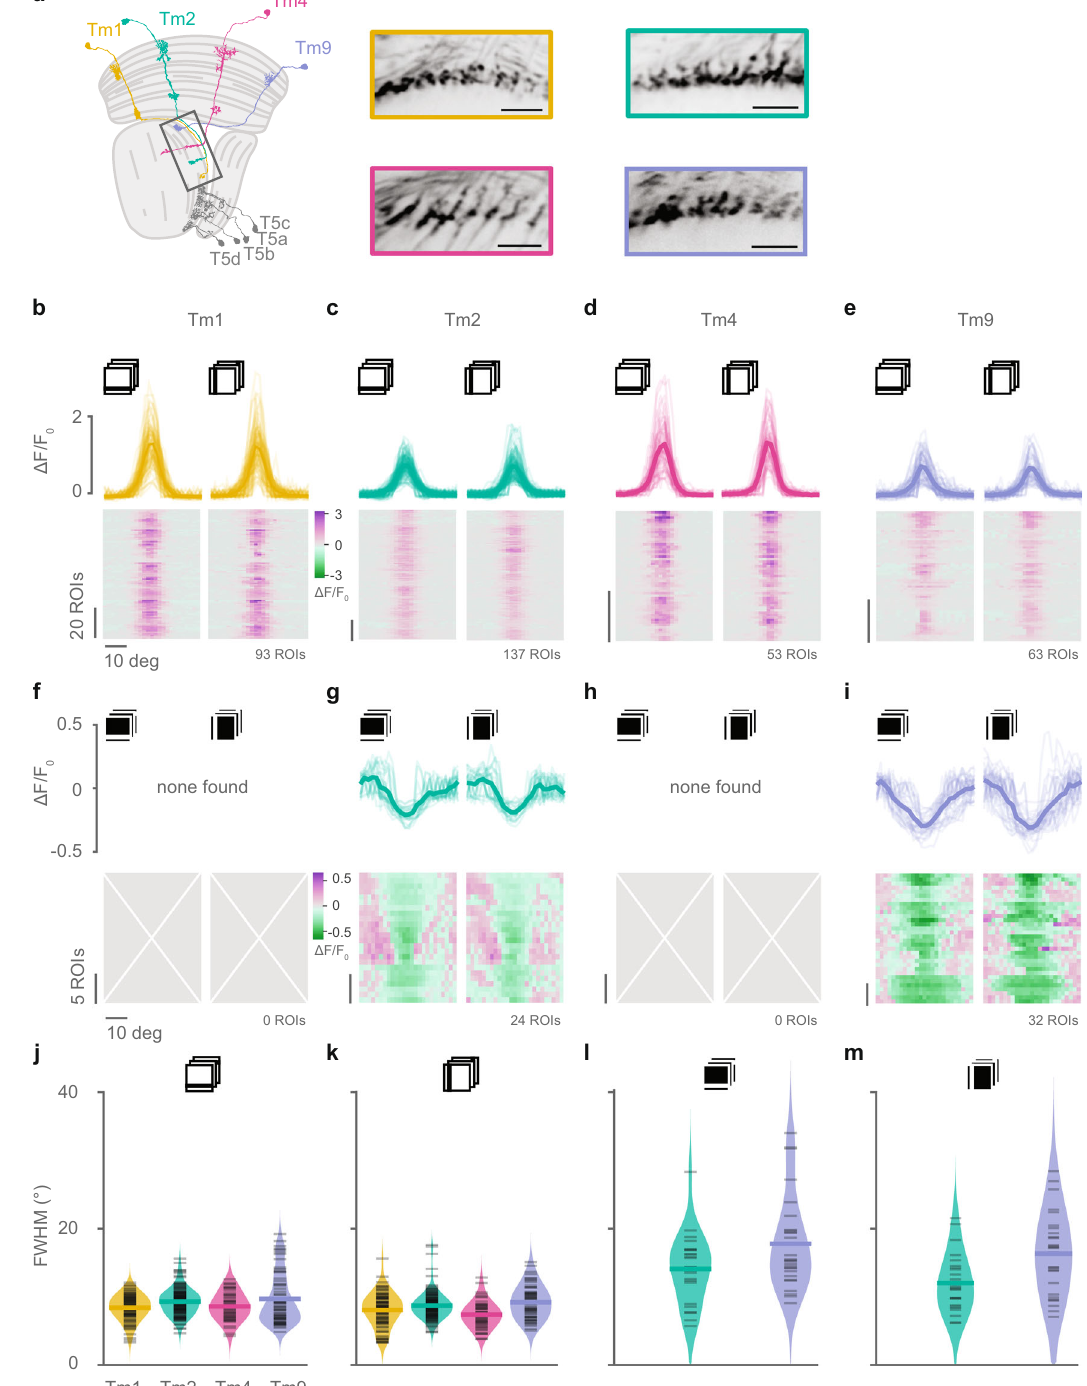
Fig. 4 Tm2 and Tm9 neurons have ON receptive fi elds. a Schematic of the optic lobe showing the anatomy of the main medulla input neurons to T5, Tm1, Tm2, Tm4, and Tm9, and example images from recordings of their axon terminals. Scale bar = 10 μ m. b – e OFF receptive fi elds obtained from in vivo two- photon calcium imaging of responses to horizontal and vertical dark bars from Tm1 ( b yellow), Tm2 ( c green), Tm4 ( d pink), and Tm9 ( e blue) neurons expressing GCaMP6f. Only neurons with responses in both orientations fi tted by a single Gaussian with r 2 > 0.2 and response quality index above 0.5 were included. Number of ROIs (neurons) is shown below the plots on the right. Thick lines are means across ROIs, thin lines are single ROIs. f – i ON receptive fi elds obtained from responses to horizontal and vertical bright bars from Tm1 ( f ), Tm2 ( g ), Tm4 ( h ), or Tm9 ( i ) neurons in b – e . Only Tm2 and Tm9 neurons had ON receptive fi elds. j – m Full width at half maximum (FWHM) from receptive fi elds obtained from horizontal OFF bars ( j ), vertical OFF bars ( k ), horizontal ON bars ( l ), and vertical ON bars ( m ). Data points correspond to neurons in b – i matching the stimulus condition. Sample sizes are Tm1 ( n = 93 ROIs), Tm2 ( n = 137 ROIs), Tm4 ( n = 53 ROIs), and Tm9 ( n = 63). ROIs come from 11 (Tm1), 15 (Tm2), 8 (Tm4), and 11 (Tm9) fl ies for all panels. Source data are provided as a Source Data fi